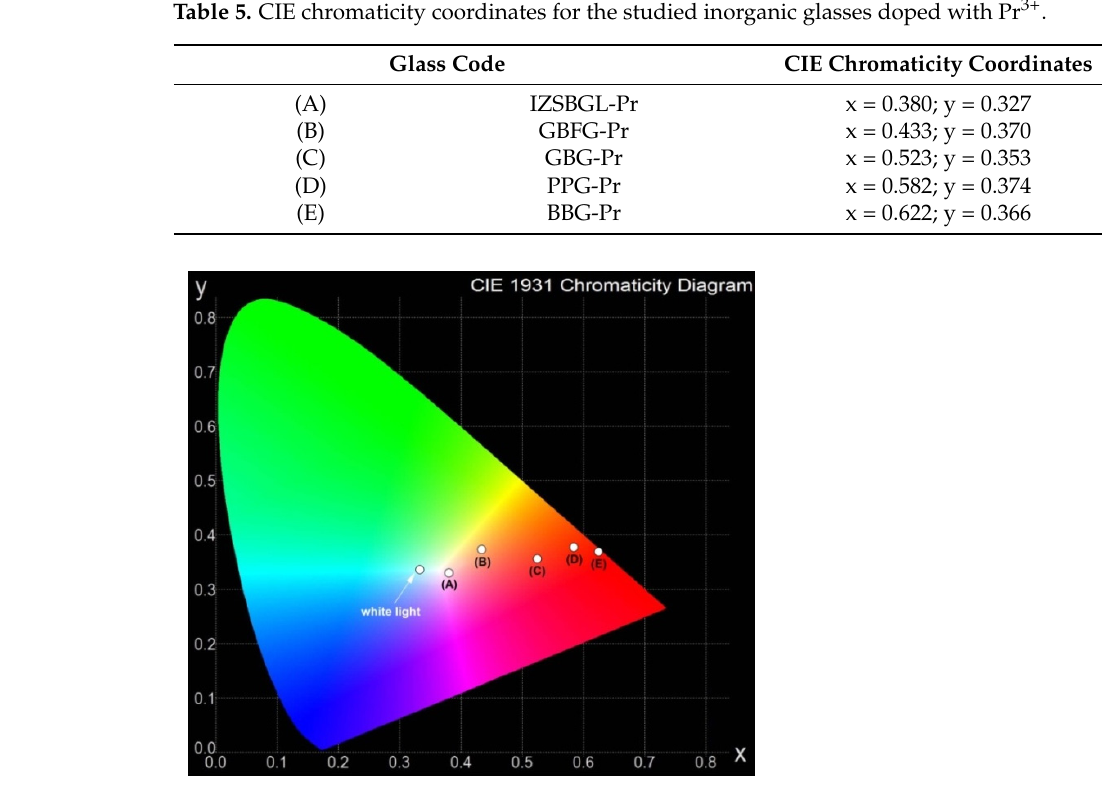
Figure 4. CIE chromaticity coordinates for IZSBGL-Pr ( A ), BGFG-Pr ( B ), BGG-Pr ( C ), PPG-Pr ( D ), and BBG-Pr ( E ) glass systems.